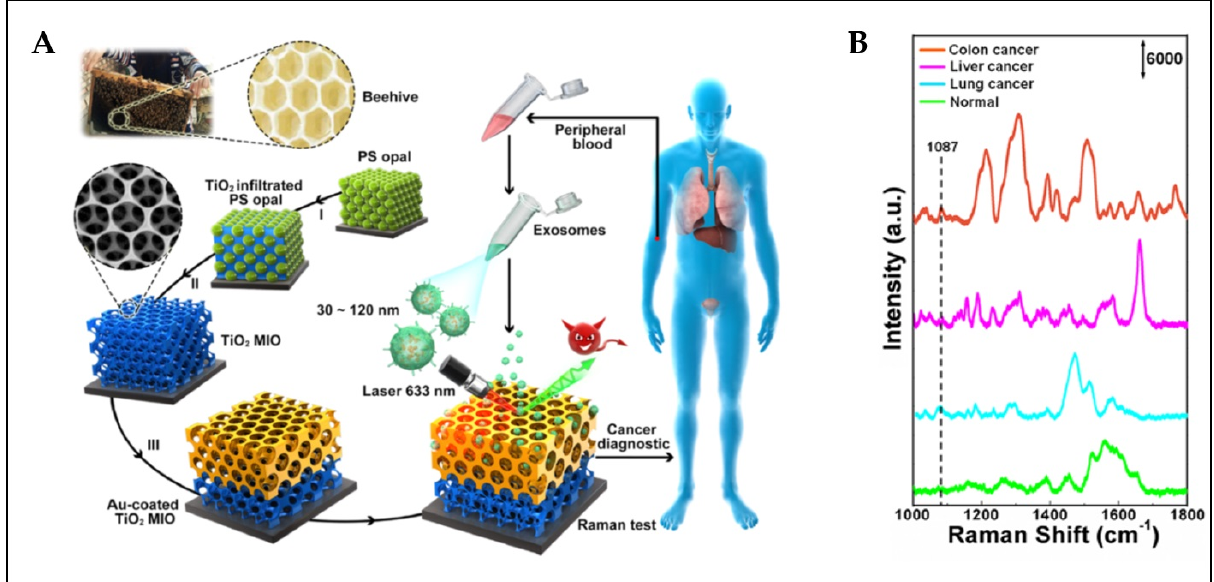
Figure 17. ( A ) Detection process and design inspiration of the Au-coated TiO 2 MIO SERS probe. ( B ) Typical SERS spectra of exosomes separated from plasma of normal individual, and lung, liver, and colon cancer patients. Reproduced with permission from [112]. Copyright 2020 American Chemical Society.